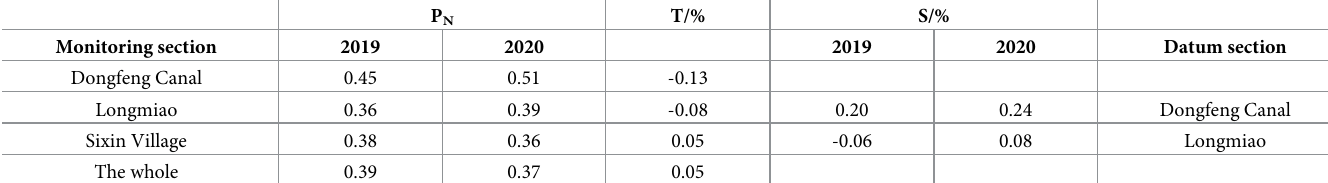
Table 7. Temporal and spatial changes of water quality in each monitoring section ofHeilongtan Reservoir from 2019 to 2020.